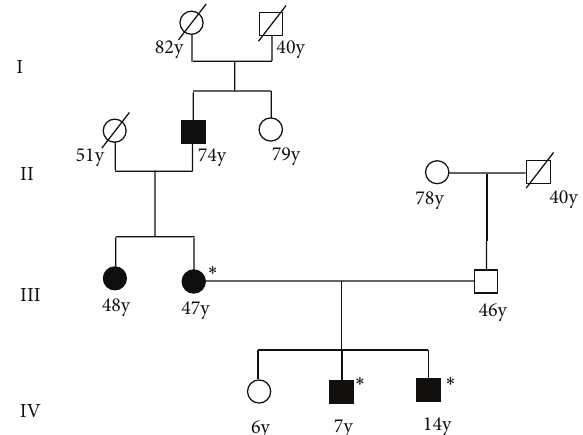
Figure 2: Pedigree of the second family with the presence of hyperferritinemia and cataract, because of the C29G mutation of the L-ferritin IRE region and H63D mutation of HFE gene. Black circles (female subjects) and squares (male subjects) indicated affected individuals (II: 1; III: 2; IV: 2) with early onset of cataract and hyperferritinemia; ∗ members heterozygous for C29G IRE mutation. The others were unavailable for mutational